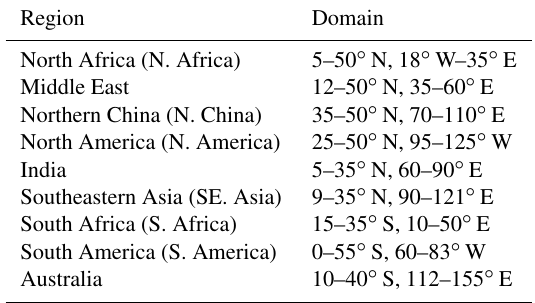
Table 2. List of regions selected to compare model output with MODIS DOD. Locations of these regions are also plotted in Fig. 1b. Acronyms are used for some regions for short, and are listed in the brackets in the first column. Note that the region names such as northern China and India are not exactly the same as their geograph- ical definitions but also cover some areas from nearby